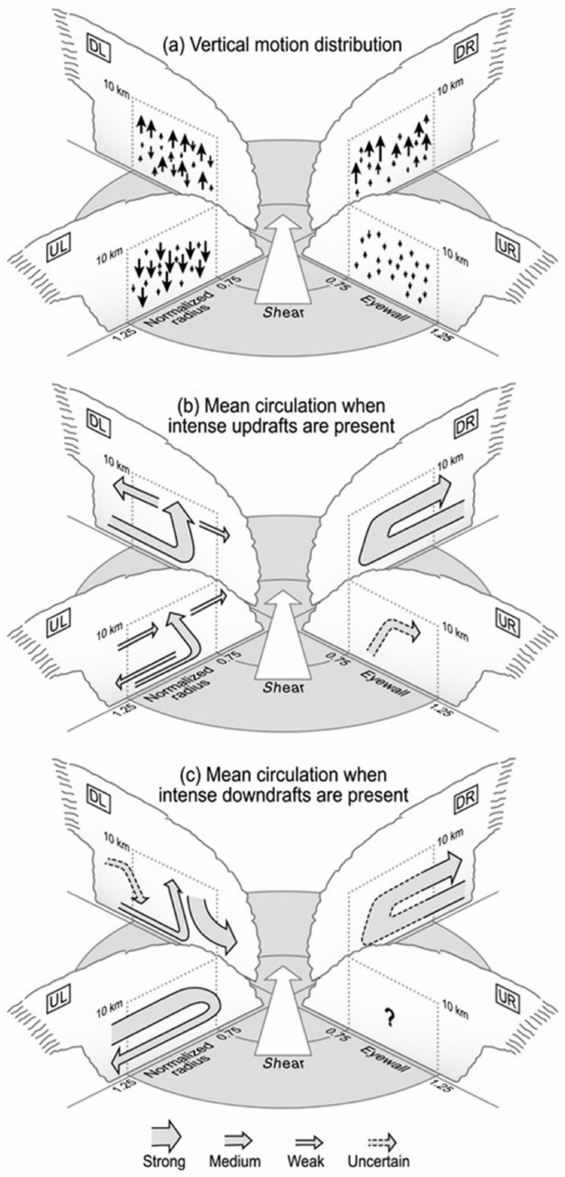
Figure 4. ( a ) Three-dimensional schematic depicting the vertical motion distribution in each quadrant. The environmental shear vector is denoted by an arrow pointing toward the top of the figure, and quadrants are labeled according to their direction relative to the shear vector (DR, DL, UL, and UR). Concentric circles below the clouds show the locations of the eyewall normalized radius values between 0.75 and 1.25), which connect to gray dashed boxes encompassing the eyewall up to 10-km altitude. Vertical arrows denote the vertical motion distribution, where size is proportional to magnitude. ( b ) As in ( a ), except illustrating the mean circulation that occurs when intense updrafts are present. Arrow width corresponds to composite velocity magnitude, as noted in the legend at the bottom. Dashed arrows refer to features that were present in the composite analysis but were shown to be not significant. ( c ) As in ( b ), except illustrating the mean circulation that occurs when intense downdrafts are present. The question mark denotes the structure existing UR is weak, disorganized, and not robust. Adapted from